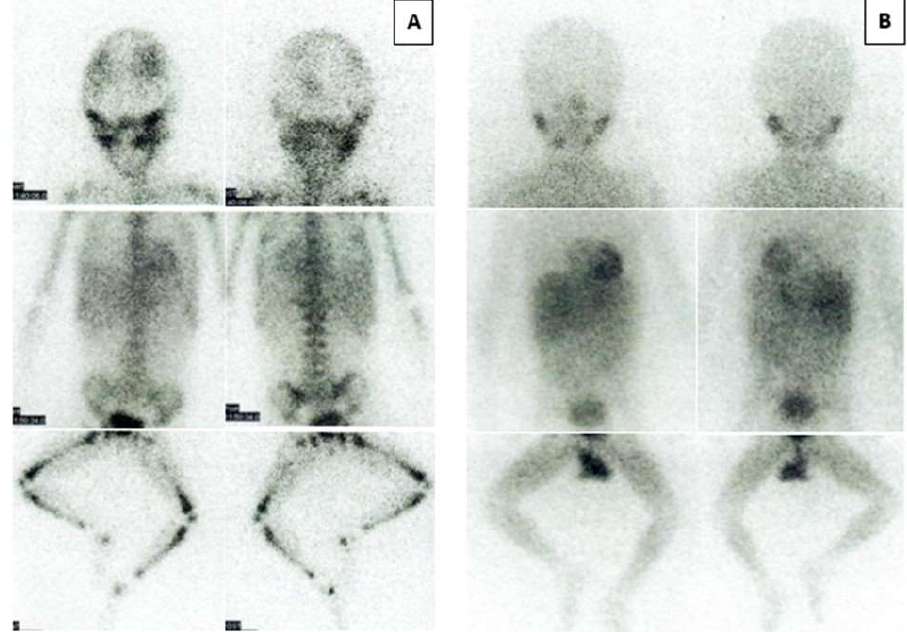
Figure 5. 123-I-MIBG skeleton images of patient number 13. Anterior ( left ) and posterior ( right ) 123-I-MIBG skeleton images before ( A ) and after ( B ) treatment.